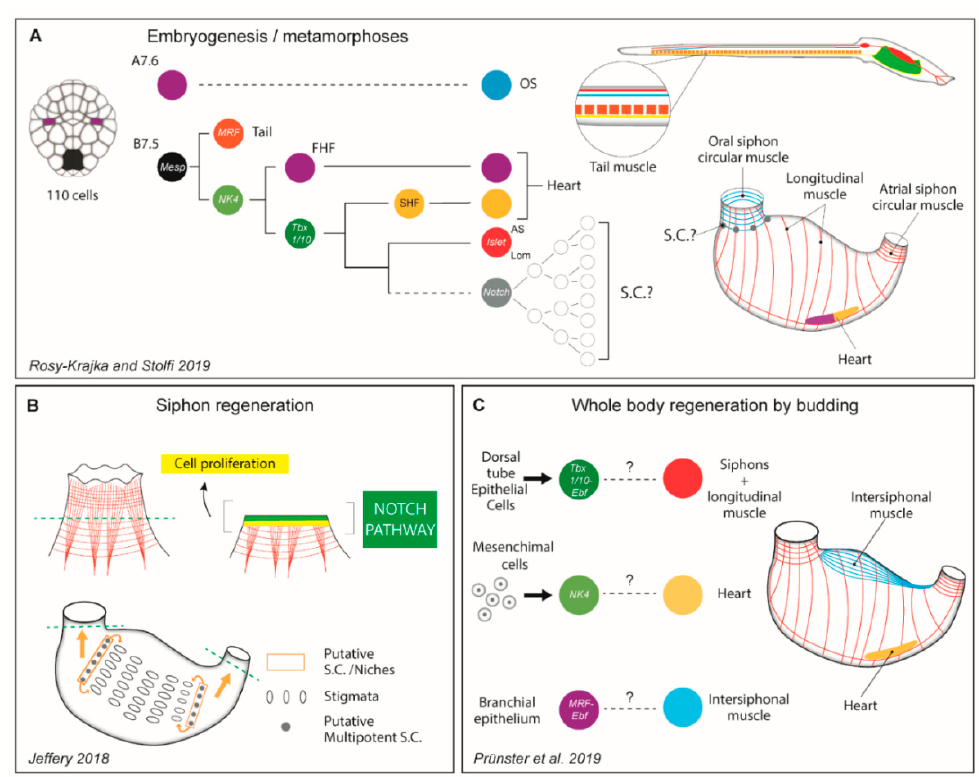
Figure 4. Ciona embryogenesis and regeneration. ( A ) Simplified scheme of muscle development during ciona embryogenesis and metamorphoses. (modified from [163]). ( B ) Scheme of oral siphon regeneration in ciona (modified from [164]). ( C ) Simplified scheme of myogenesis during budding in Botryllus schlosseri . FHF: first heart field; SHF: second heart field; OS: oral siphon; AS: atrial siphon; LoM: longitudinal muscles; SC: stem cells.